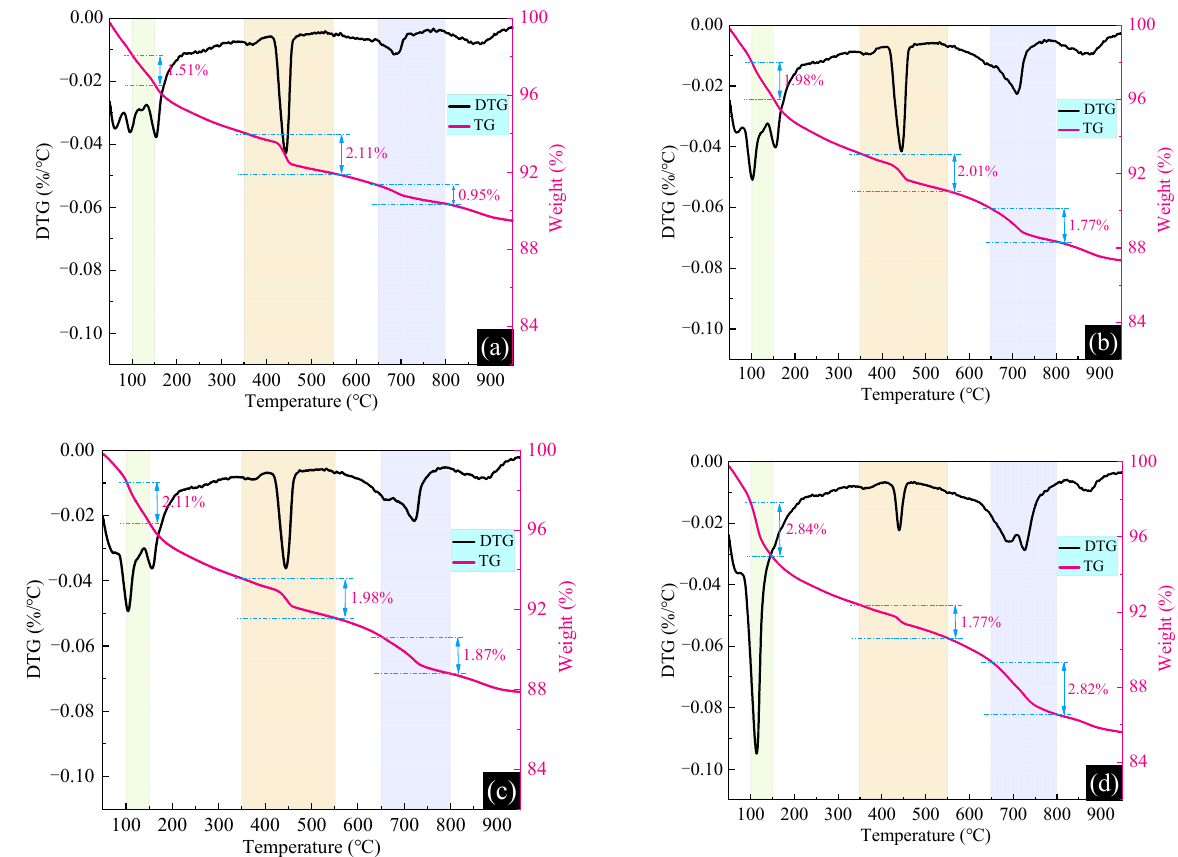
Figure 9. The TG/DTG curves of MTSC. ( a ) MTSC-0, ( b ) MTSC-3, ( c ) MTSC-4, ( d ) MTSC-10.